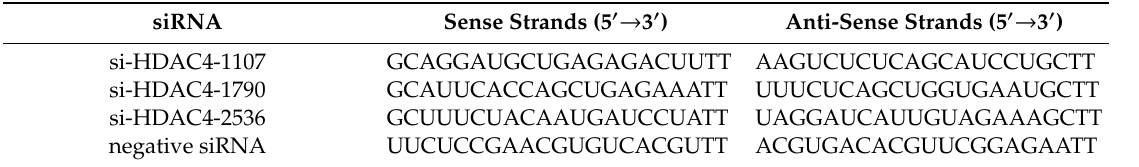
Table 1. Design of siRNA target on CDS of chicken HDAC4 siRNA